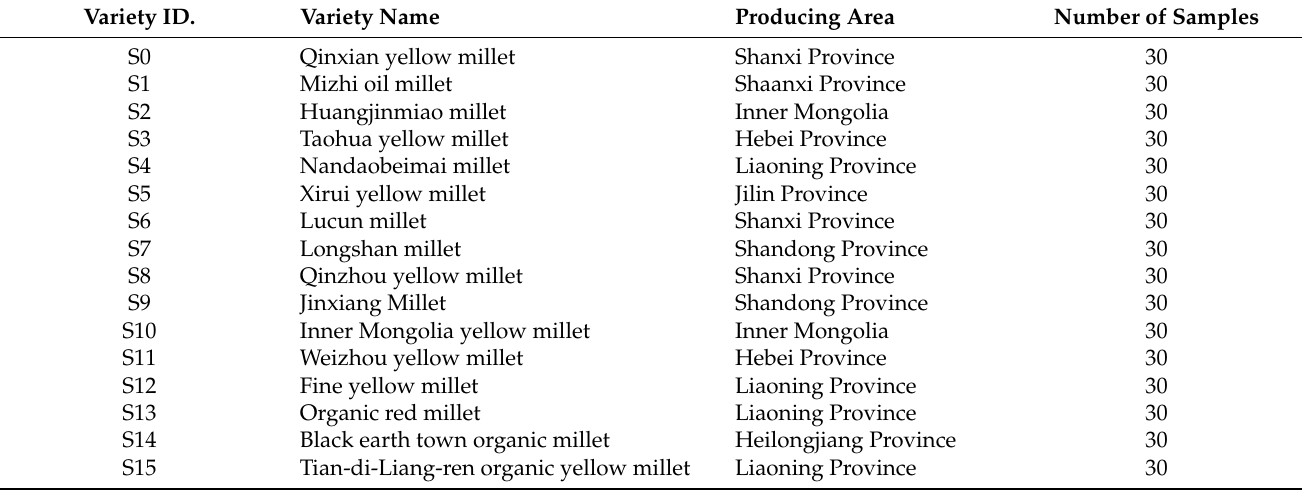
Table 1. Samples of varieties from different geographic